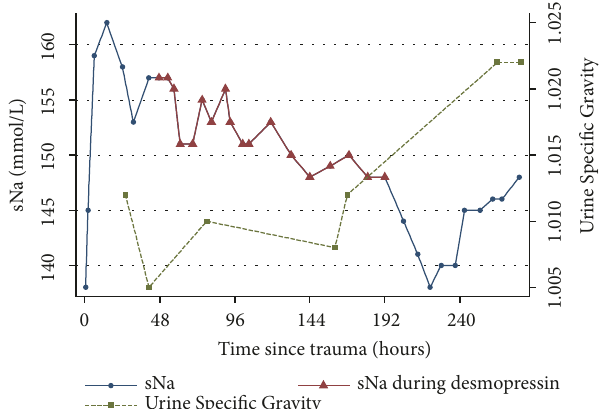
Figure 1: Serum Na concentrations are shown on the left vertical axis, with red triangles showing when desmopressin treatment startedandended,andurinespecificgravityontherightverticalaxis (generated using Stata v14 (StataCorp LP, College Station,